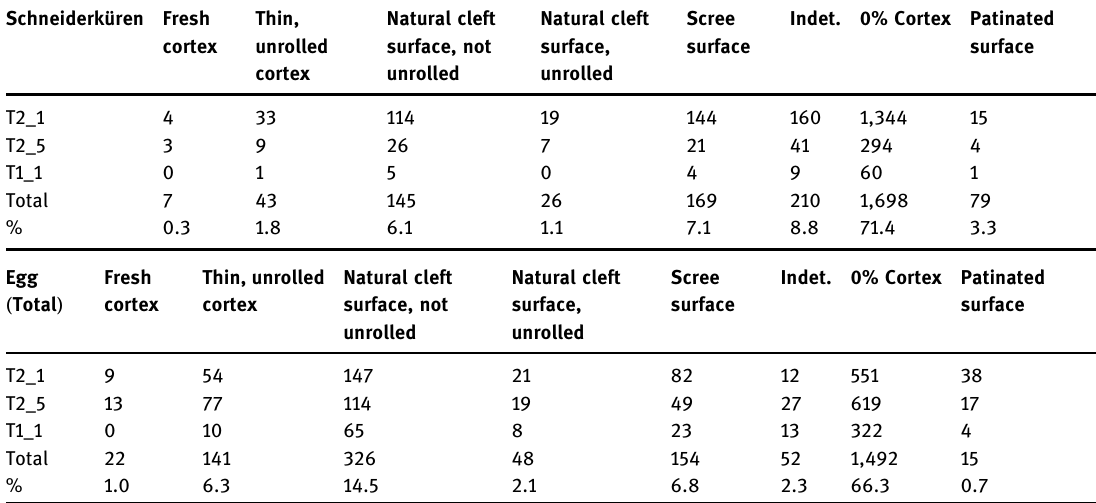
Table 15: Cortex types and coverage of local raw material varieties Schneiderküren and Egg - Schwarzwasser Schneiderküren Fresh